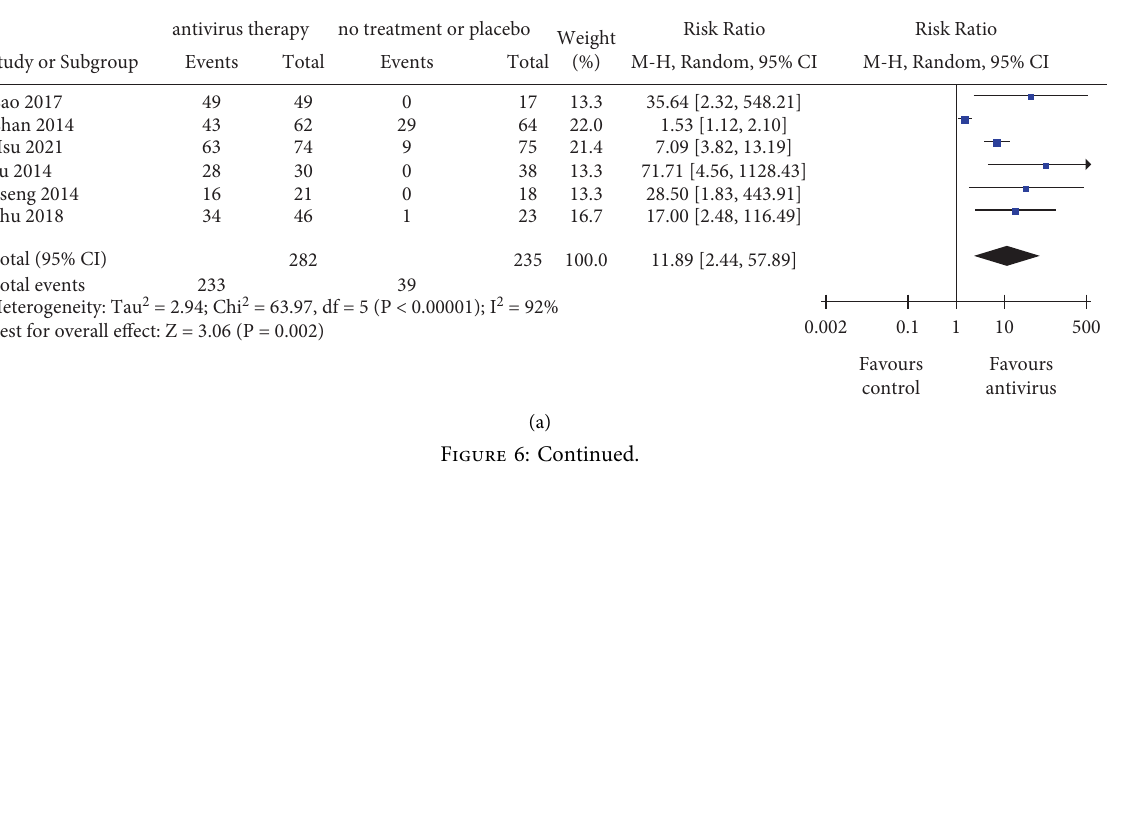
Figure 5: Te outcomes of HBeAg seroconversion. (a) Pooled risk ratio for HBeAg seroconversion between the antiviral therapy group and control group. (b) Subgroup analysis stratifed by therapeutic regimen with or without IFN. (c) Subgroup analysis stratifed by monotherapy and combined therapy (IFN plus NAs). (d) Subgroup analysis stratifed by therapy duration with threshold of 96 weeks. NAs, nucleos(t)ide analogs; IFN, interferon; CI, confdence interval; monotherapy group exclusively included NAs or IFN. Te size of square represents the weight of each study, and the vertical dotted line represents the pooled rate.